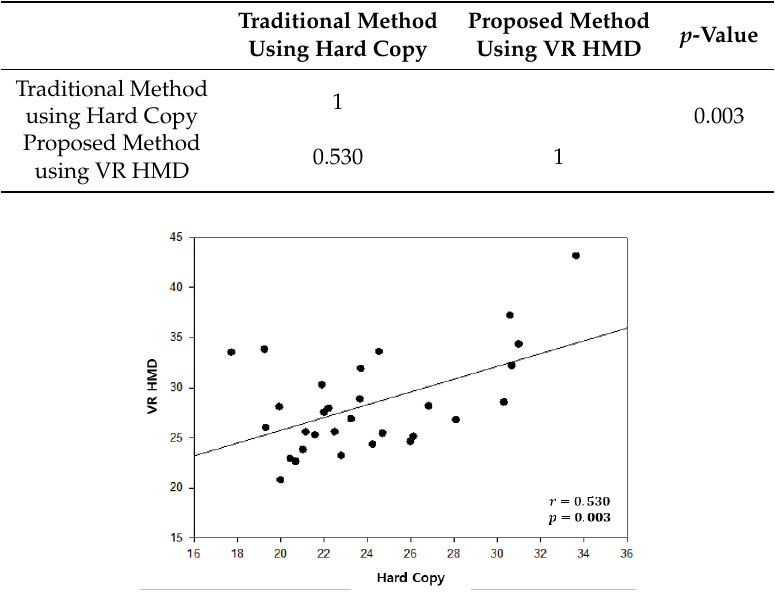
Table 6. Correlation between the vertical tests of the traditional method and the proposed method.